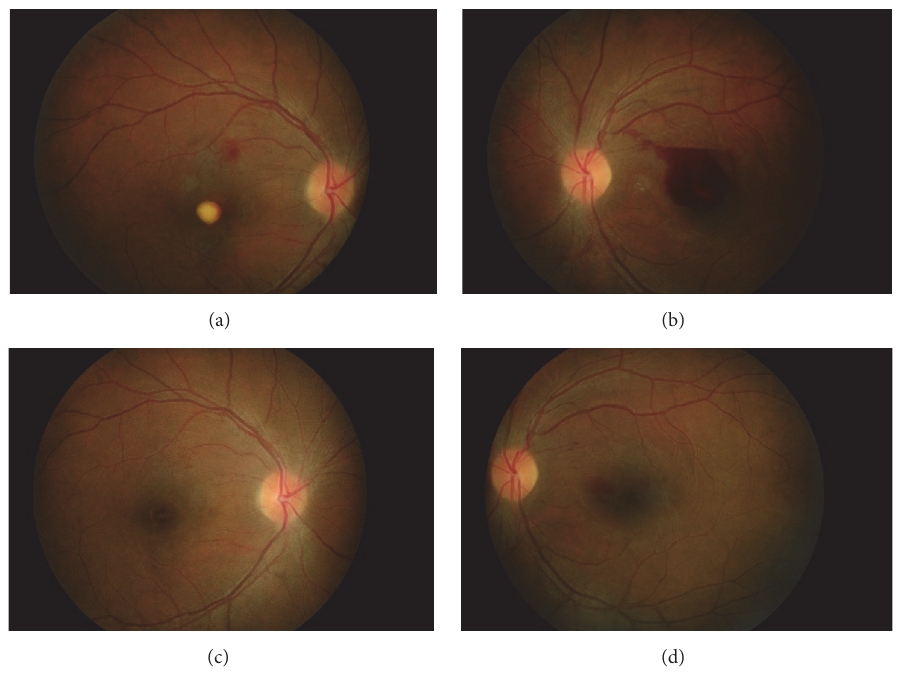
Figure 2: Case 1 at 6 weeks and 3 months after initial presentation. Notes: (a) premacular exudate in the right eye at 1 month after first left intravitreal ranibizumab (6 weeks after initial presentation), (b) partial resolution of premacular haemorrhage in the left eye at 1 month after first left intravitreal ranibizumab (6 weeks after initial presentation), (c) complete resolution of premacular haemorrhage in the right eye at 1 month after second left intravitreal ranibizumab (3 months after initial presentation), and (d) minimal residual premacular haemorrhage in the left eye at 1 month after second left intravitreal ranibizumab (3 months after initial